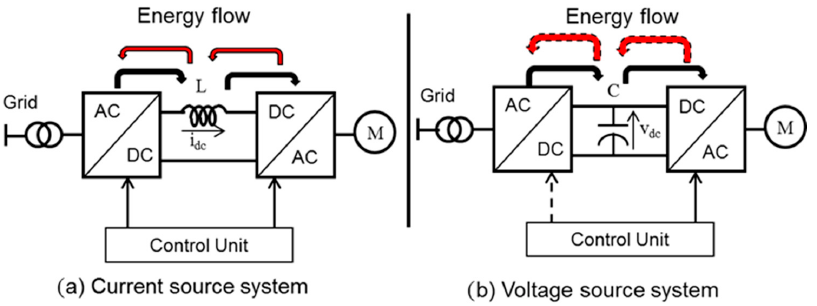
Figure 1. Simplified representation of current source and voltage source VFDs: ( a ) current source system, where the DC tank is an inductance and the AC/DC stage is controlled; ( b ) voltage source system, where the DC tank is a capacitor and the control of the AC/DC stage is optional.